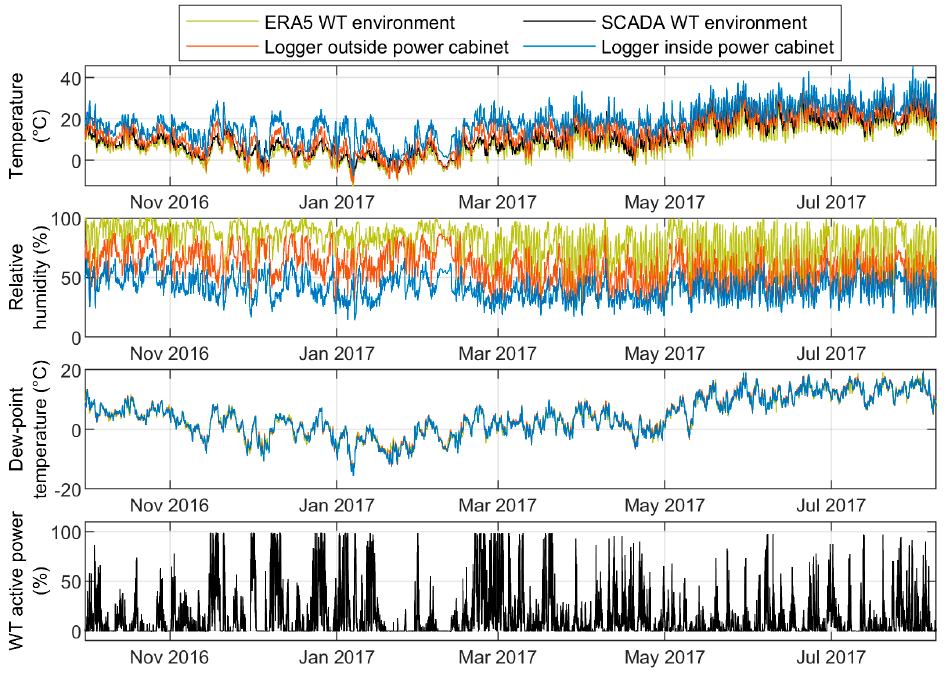
Figure 5. Measured climatic data, SCADA and ERA5 data from an onshore wind turbine in Germany with air-cooled converter located in the tower base.